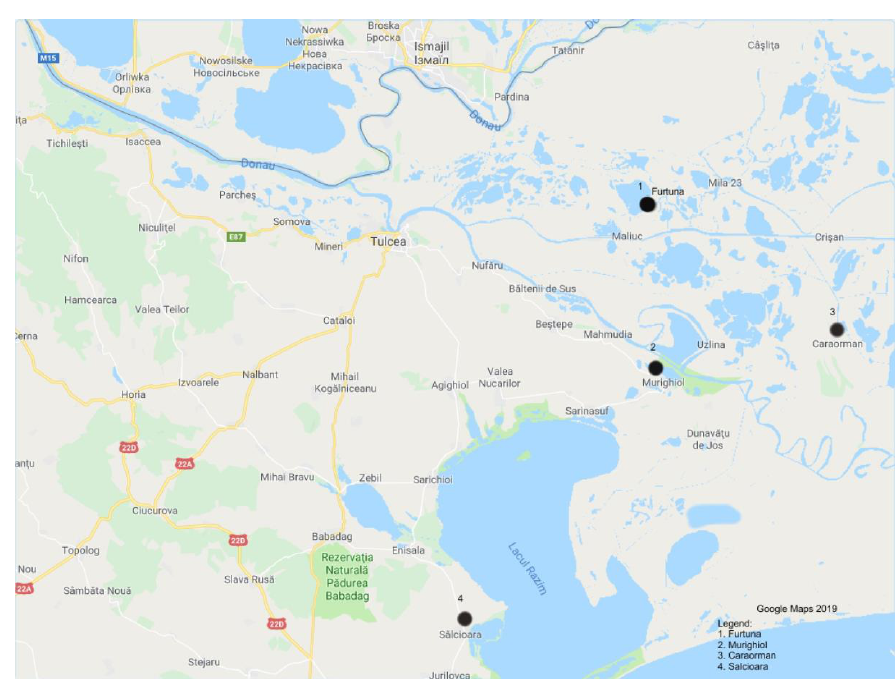
Figure 1. Map of the Danube Delta Biosphere Reserve (DDBR) with sampling